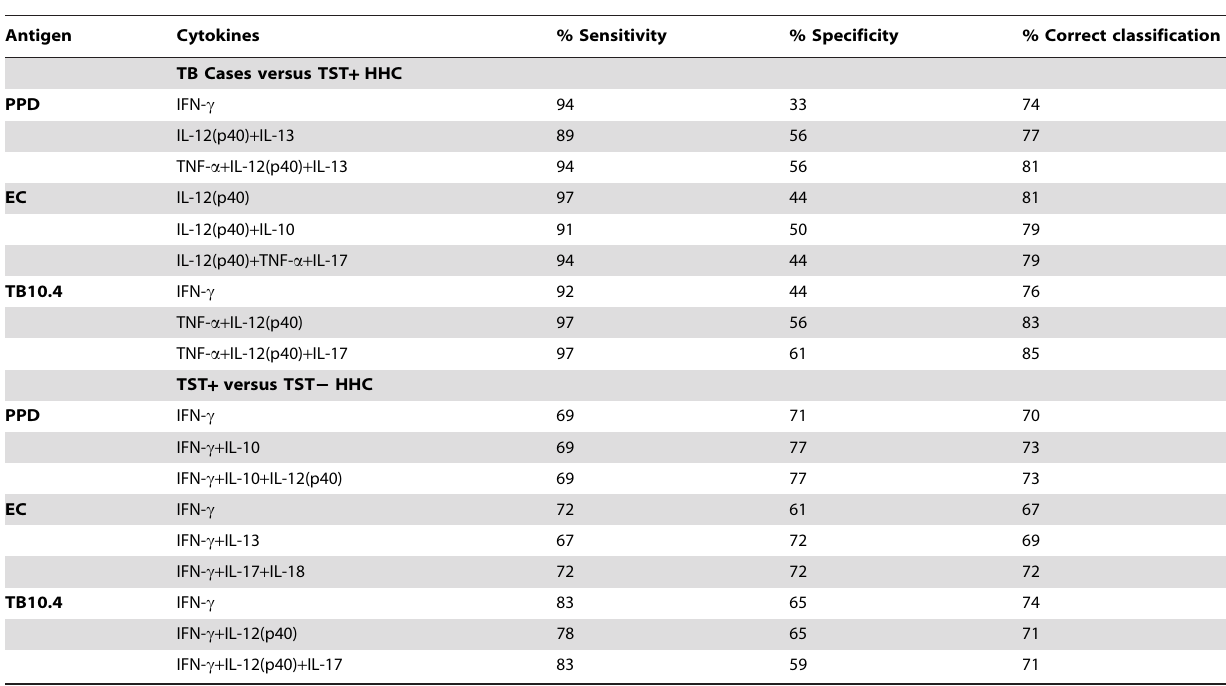
Table 1. Multivariate analysis for classification into TB cases, TST + or TST 2 contacts.